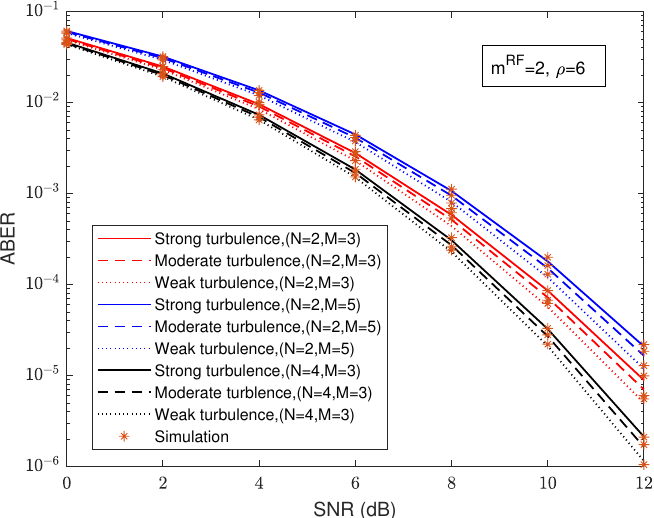
Figure 4. Relationship between the ABER and the SNR of the multi-hop parallel hybrid system under different relay-assisted structures and turbulence